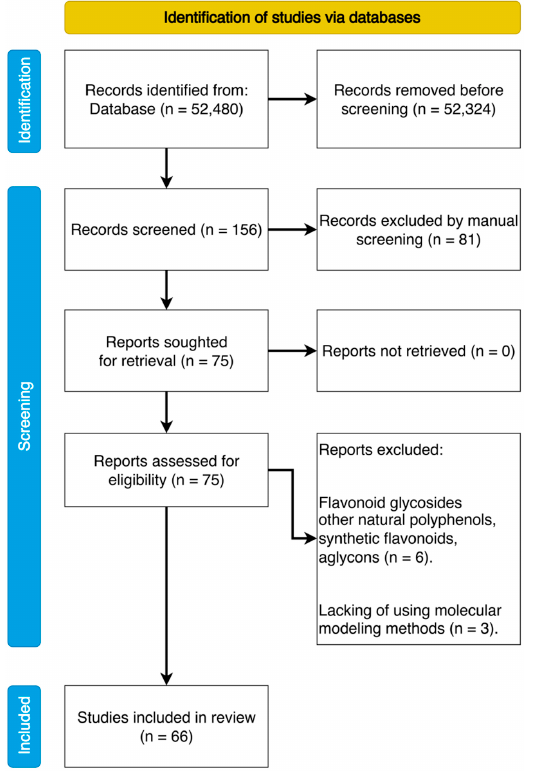
Figure 2. PRISMA flowchart of the search and selection process of the articles.